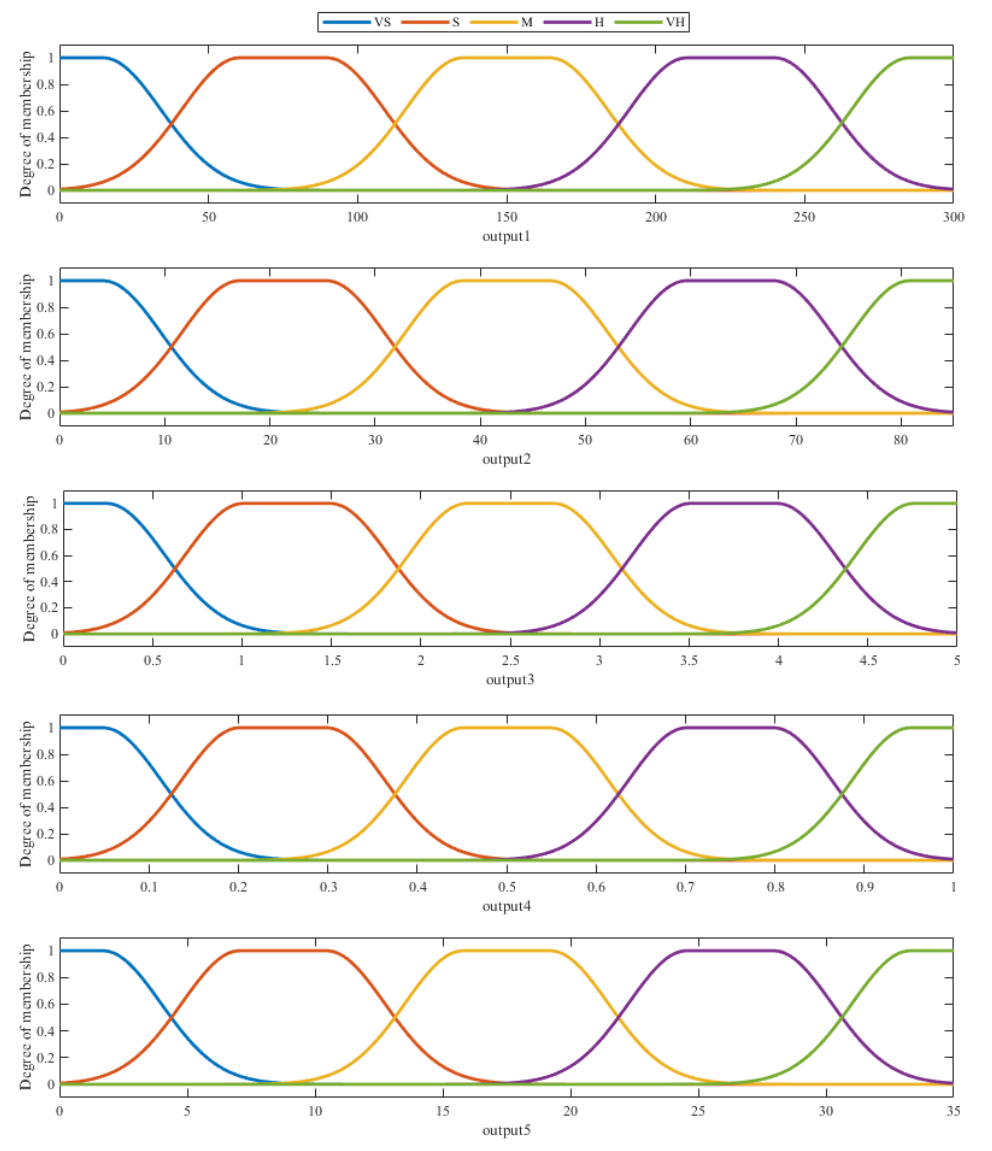
Figure 6. Output membership function for Scenarios 2 and